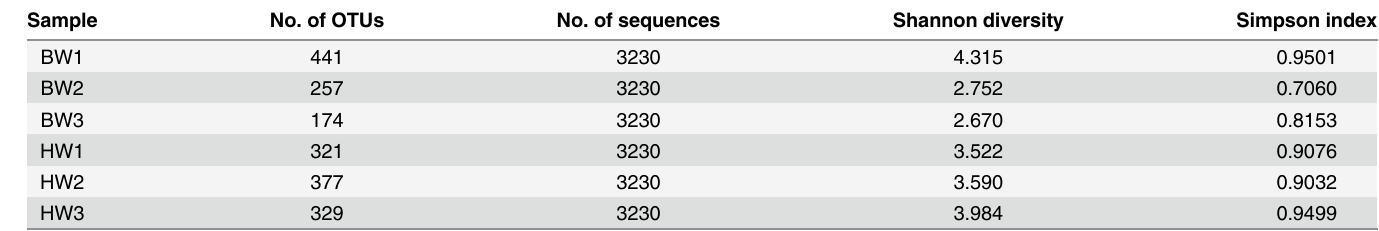
Table 2. Diversity of microbial community composition between samples. Sample